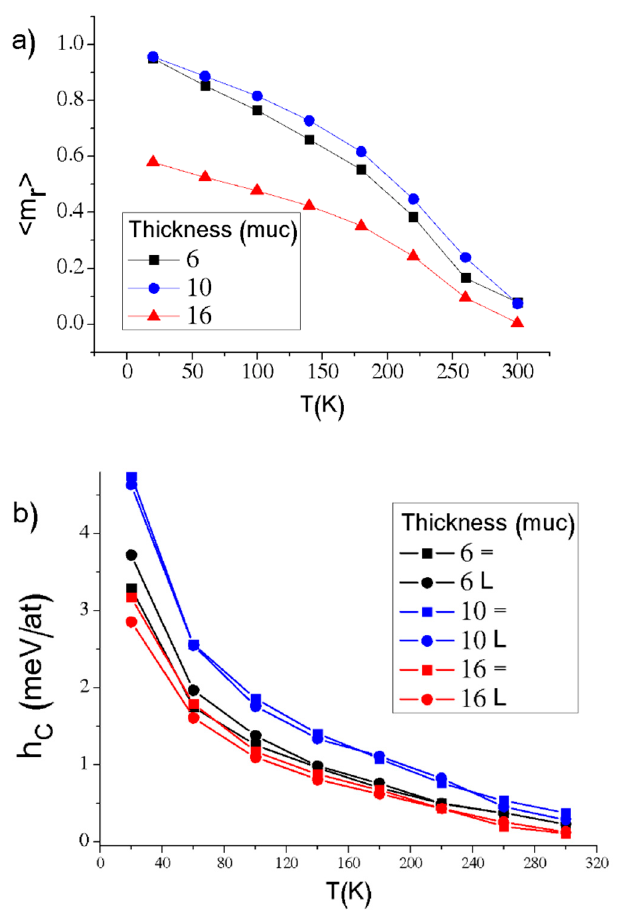
Figure 10. ( a ) Remanence magnetization, and ( b ) a coercive field as a function of the temperature at different thicknesses. The symbols ‘=’ and ‘ ∟ ’ represent parallel and perpendicular external field directions, respectively.